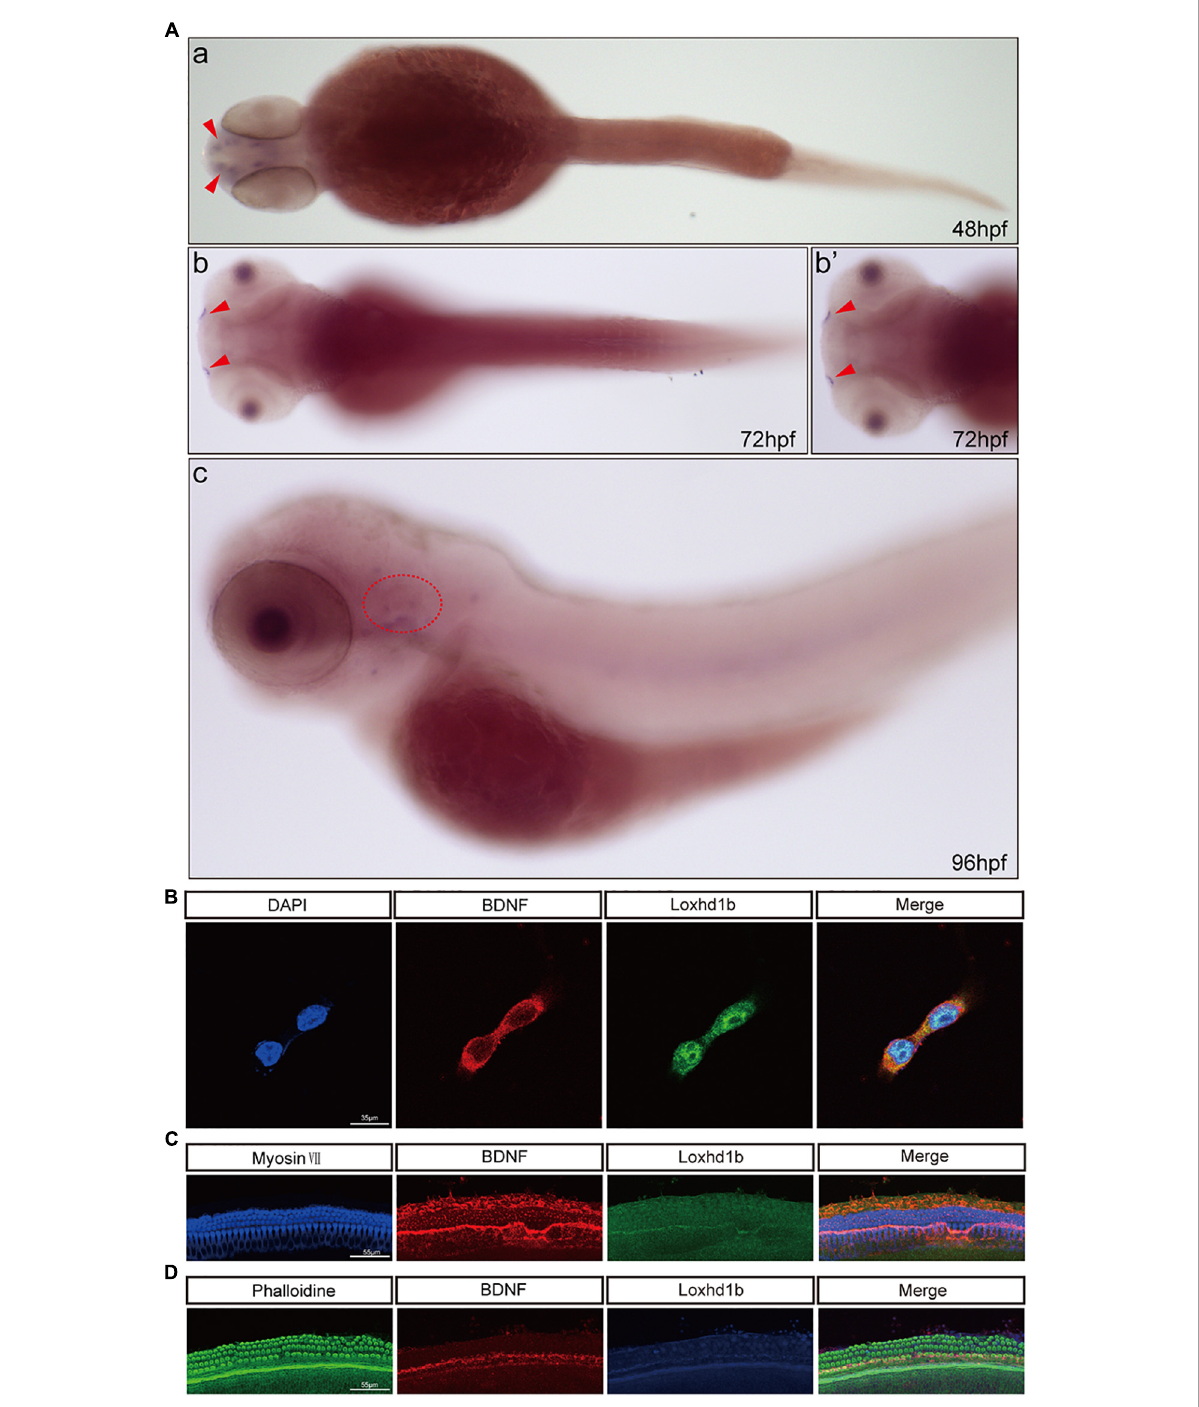
FIGURE7 Co-localization of Loxhd1b and BDNF. (A) In situ hybridization at 48–96 hpf showing that BDNF is expressed around the inner ear and olfactory pore of zebrafish, suggesting the effect of BDNF on hearing development. The red arrow indicates the olfactory pore of the zebrafish, and the red dotted circle indicates the inner ear of the zebrafish. (B) Immunofluorescence staining of Loxhd1b and BDNF in HEI-OC1 cells. The nuclei are stained blue by DAPI. Scale bar = 35 µ m. (C) Representative images of inner ear hair cells in cochleae from C57 mice of 7 days old. The inner ear hair cells are labeled with Myosin VII (blue). Scale bar = 55 µ m. (D) Representative images of inner ear hair cells in cochleae from p57 mice of 7 days old. Phalloidin is used to label the inner ear hair cells (green). Scale bar = 55 µ